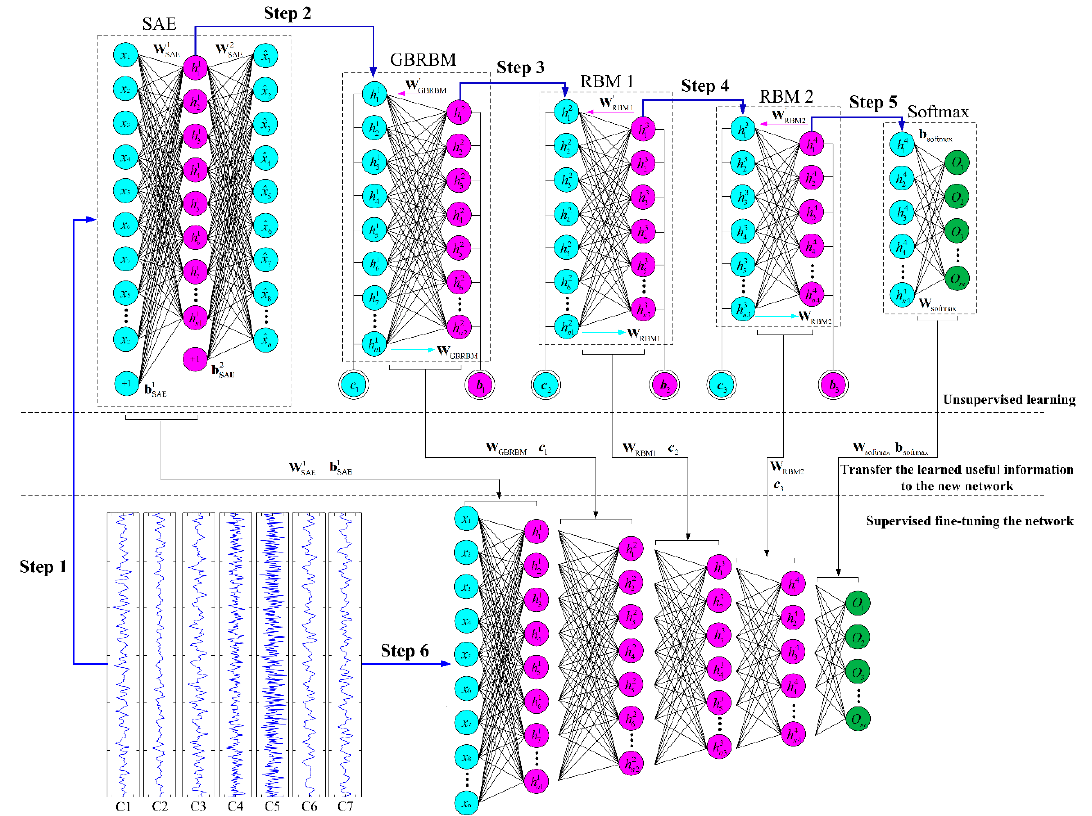
Figure 1. The framework of the proposed method.